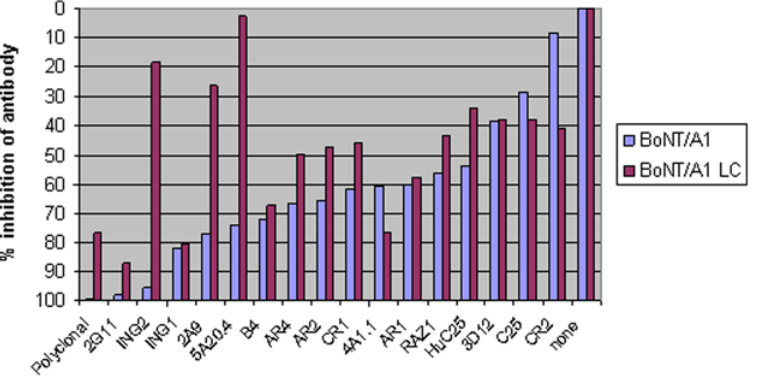
Figure 1. A graph indicating the % of inhibition in activity of BoNT/A1 or /A1 light chain following neutralization with the antibody panel. The sample with no antibodies had no inhibition of activity, so the % of inhibition in activity is calculated by dividing the peak area ratio of the peptide cleavage product over the internal standard peptide of the individual antibody by the peak area ratio of the sample with no antibodies.